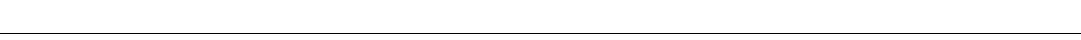
Figure 1 | Genome-wide high-throughput siRNA-based screening in NCI-H1819 cells. ( a ) Flow chart of the project. ( b ) NCI-H1819 cells do not express SMARCA4. The endogenous levels of SMARCA4 and ectopic expression of SMARCA4-FLAG in HBEC30-KT, NCI-H1819 and NCI-H1819 infected with pBABE or pBABE-SMARCA4-FLAG were measured by western blotting. ( c ) Schematic representation of the results from screening pooled siRNAs for each of 21,124 human genes in NCI-H1819 cells. Cell viability after the knockdowns was determined with a CellTiter-Glo assay, which measures cellular ATP as an indicator of living cells. Robust z -scores for triplicate samples of each siRNA pool were calculated and genes with a z -score o (cid:2) 3 were selected as statistically significant. ( d ) Mean viability for triplicate biological replicates of each siRNA pool with a z -score o (cid:2) 3 was determined and genes with viability o 50% were selected for further analysis. ( e ) Thirty-eight differentially toxic hits were re-analysed and 30 significantly reduced the viability